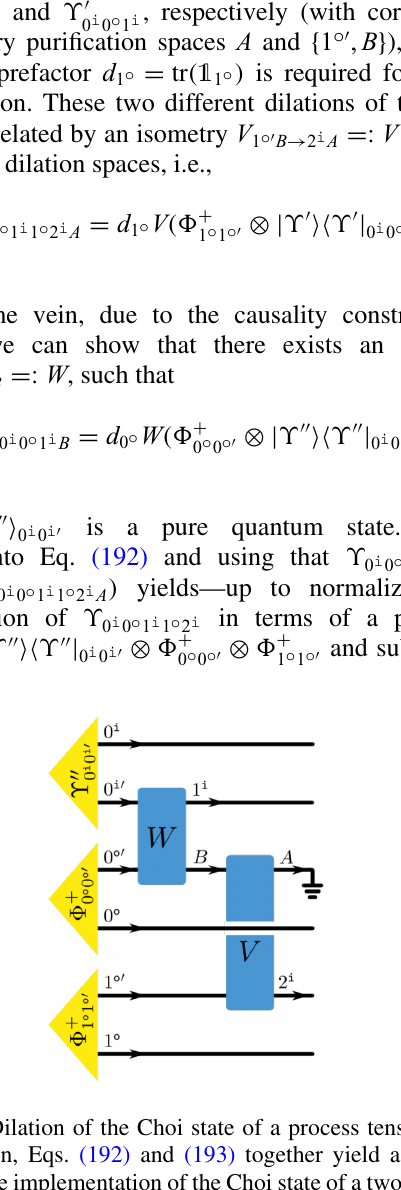
∼= H o ∼= H o and H o , such that 0 1 0 (cid:10) 1 (cid:10) 0 i 0 o 1 i 1 o 2 i